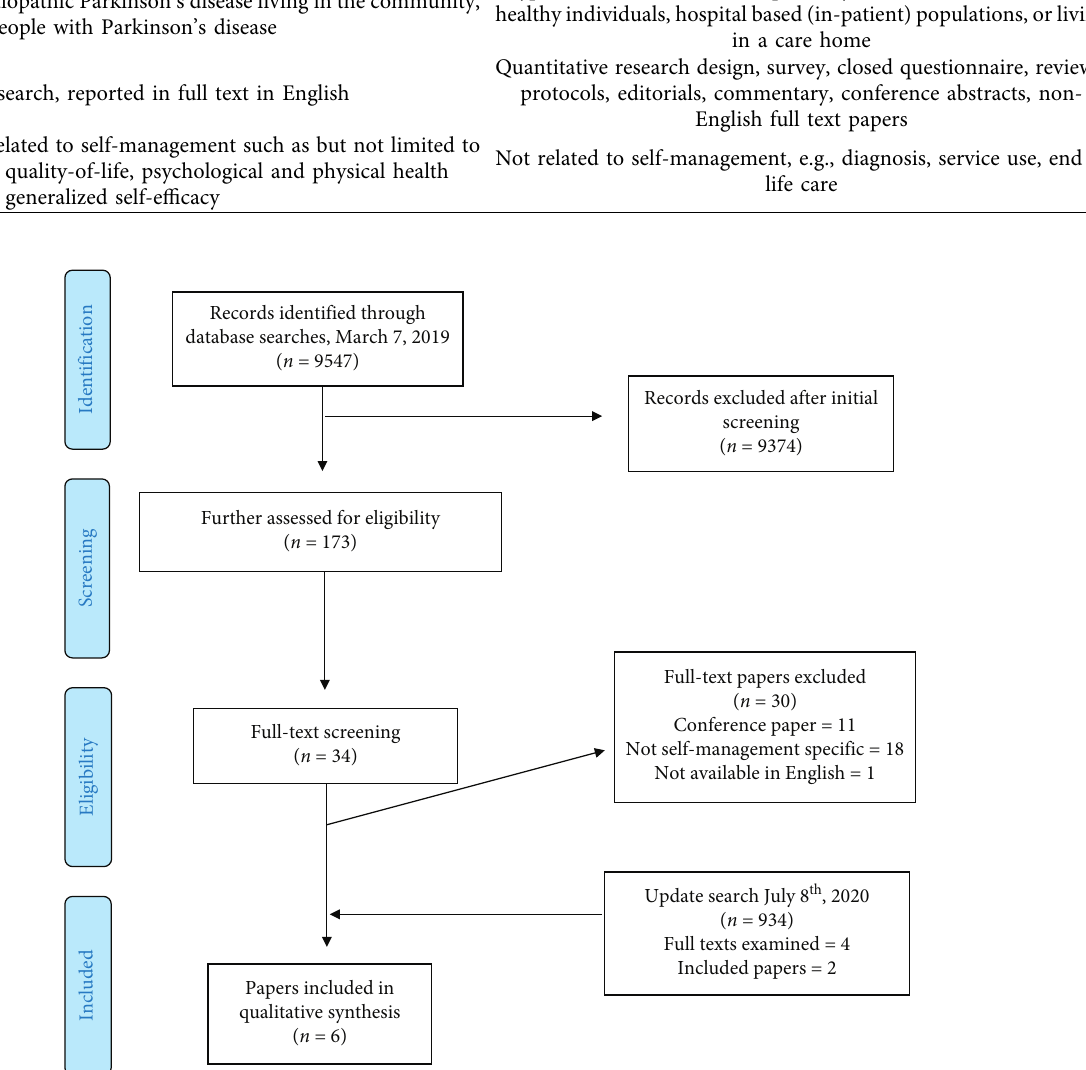
Figure 1: PRISMA flow diagram of included studies.